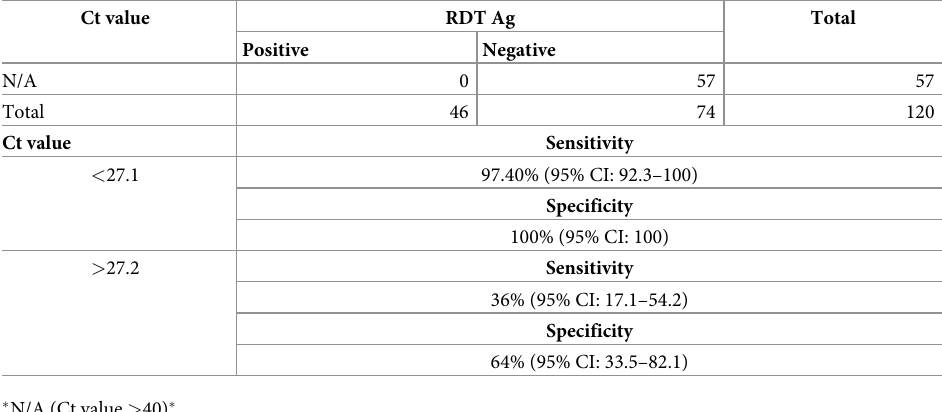
Table 3. Detection rate of Abbot RDT-Ag test as compared with Ct values (N =